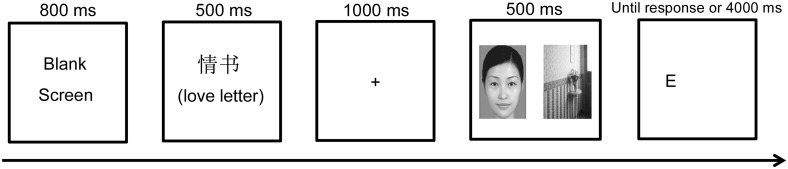
Example of the dot-probe paradigm procedure.This example shows a congruent trial of the attractive female-neutral picture pair in the love-priming condition.